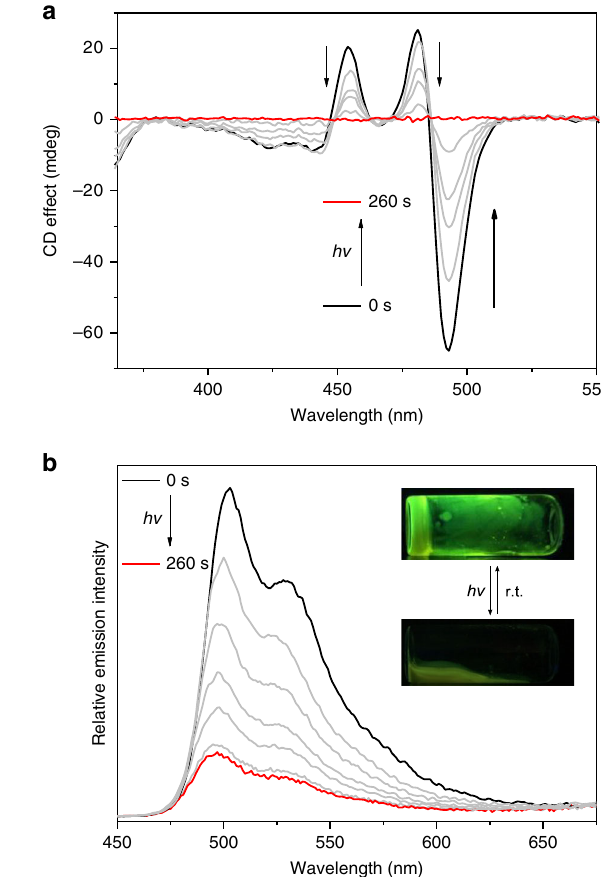
Fig. 7 Photo-switching of supramolecular polymers from 1 . a CD and b fl uorescent spectra of 1 (2.00 × 10 − 4 M in MCH at 298 K) upon 460 nm light irradiation for 260 s. Inset of b : gel – sol transition of 1 (10.0 mM in MCH) upon the successive 460 nm light irradiation and standing at room Fig. 24). For a 10:1 mixture of 1 and 2 in MCH, Φ ET (energy transfer ef fi ciency) and k ET (energy transfer rate constant) are